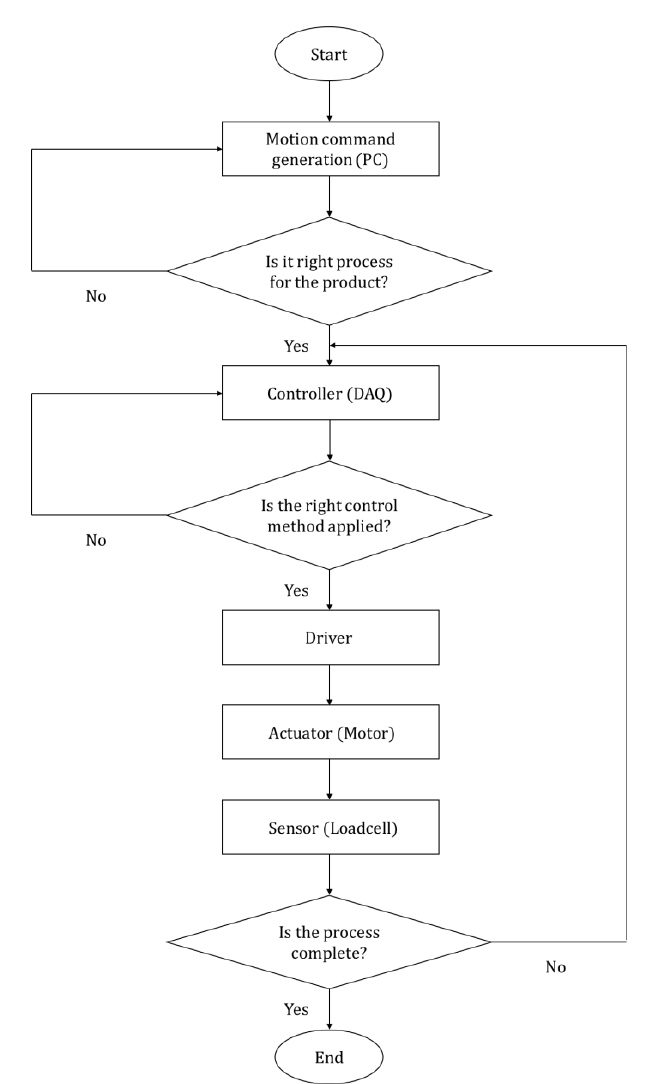
Figure 9. Overall program flow chart for R2R system.